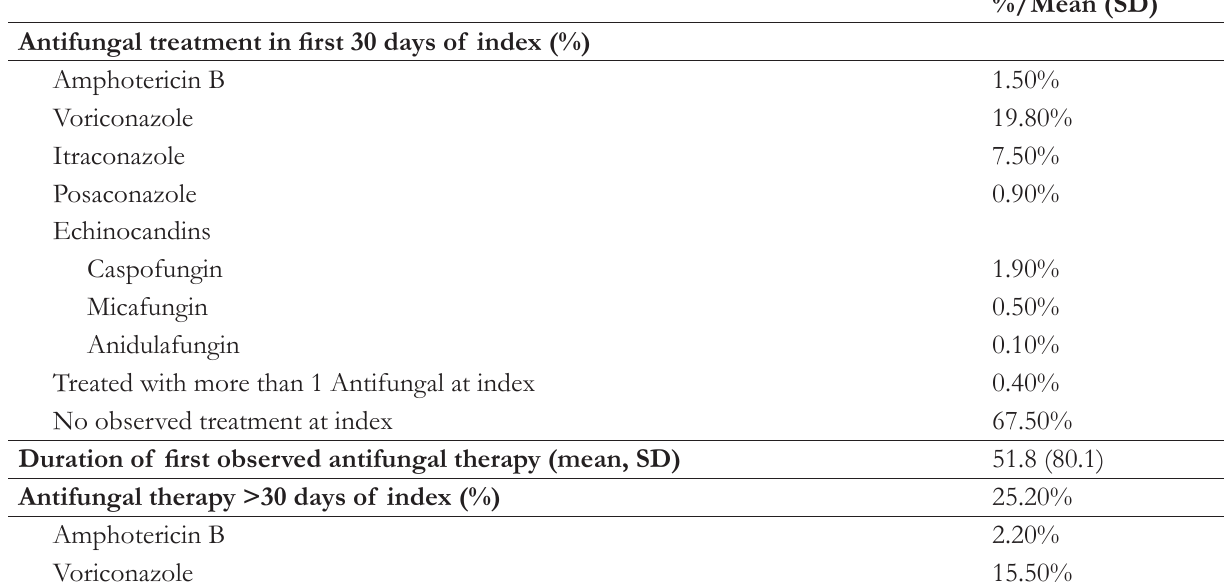
Table 3. Post-Index Outpatient Antifungal and Other Therapies of Aspergillosis Cases Antifungal treatment in first 30 days of index